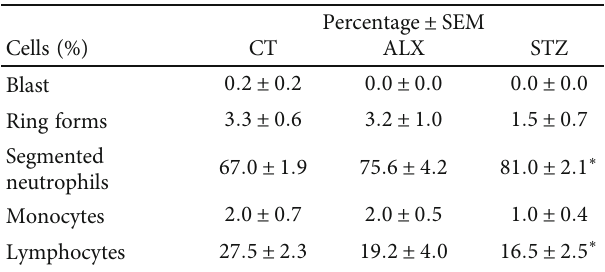
Table 1: STZ-treated animals showed an increase in the percentage of neutrophils and a decrease in lymphocytes in the bone marrow. Data are presented as percentage ± SEM , ∗ p ≤ 0 : 05 (5-6 animals per